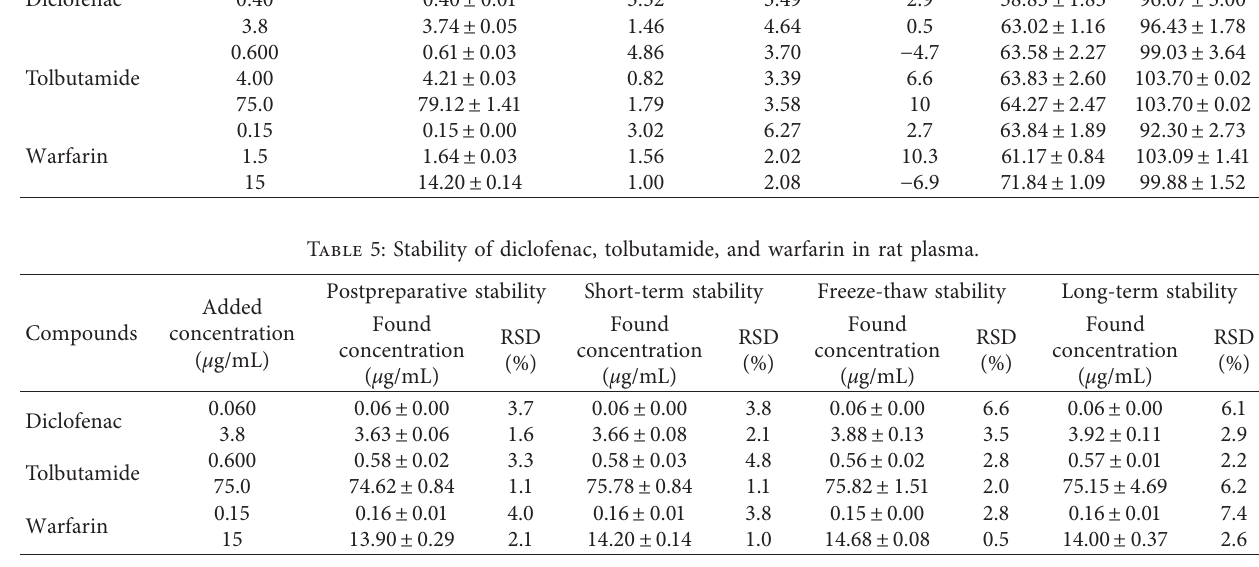
Table 4: Intraday/interday accuracy, precision, recovery, and matrix effect of diclofenac, tolbutamide, and warfarin in rat plasma. Added concentration Found concentration Compounds ( μ g/mL)